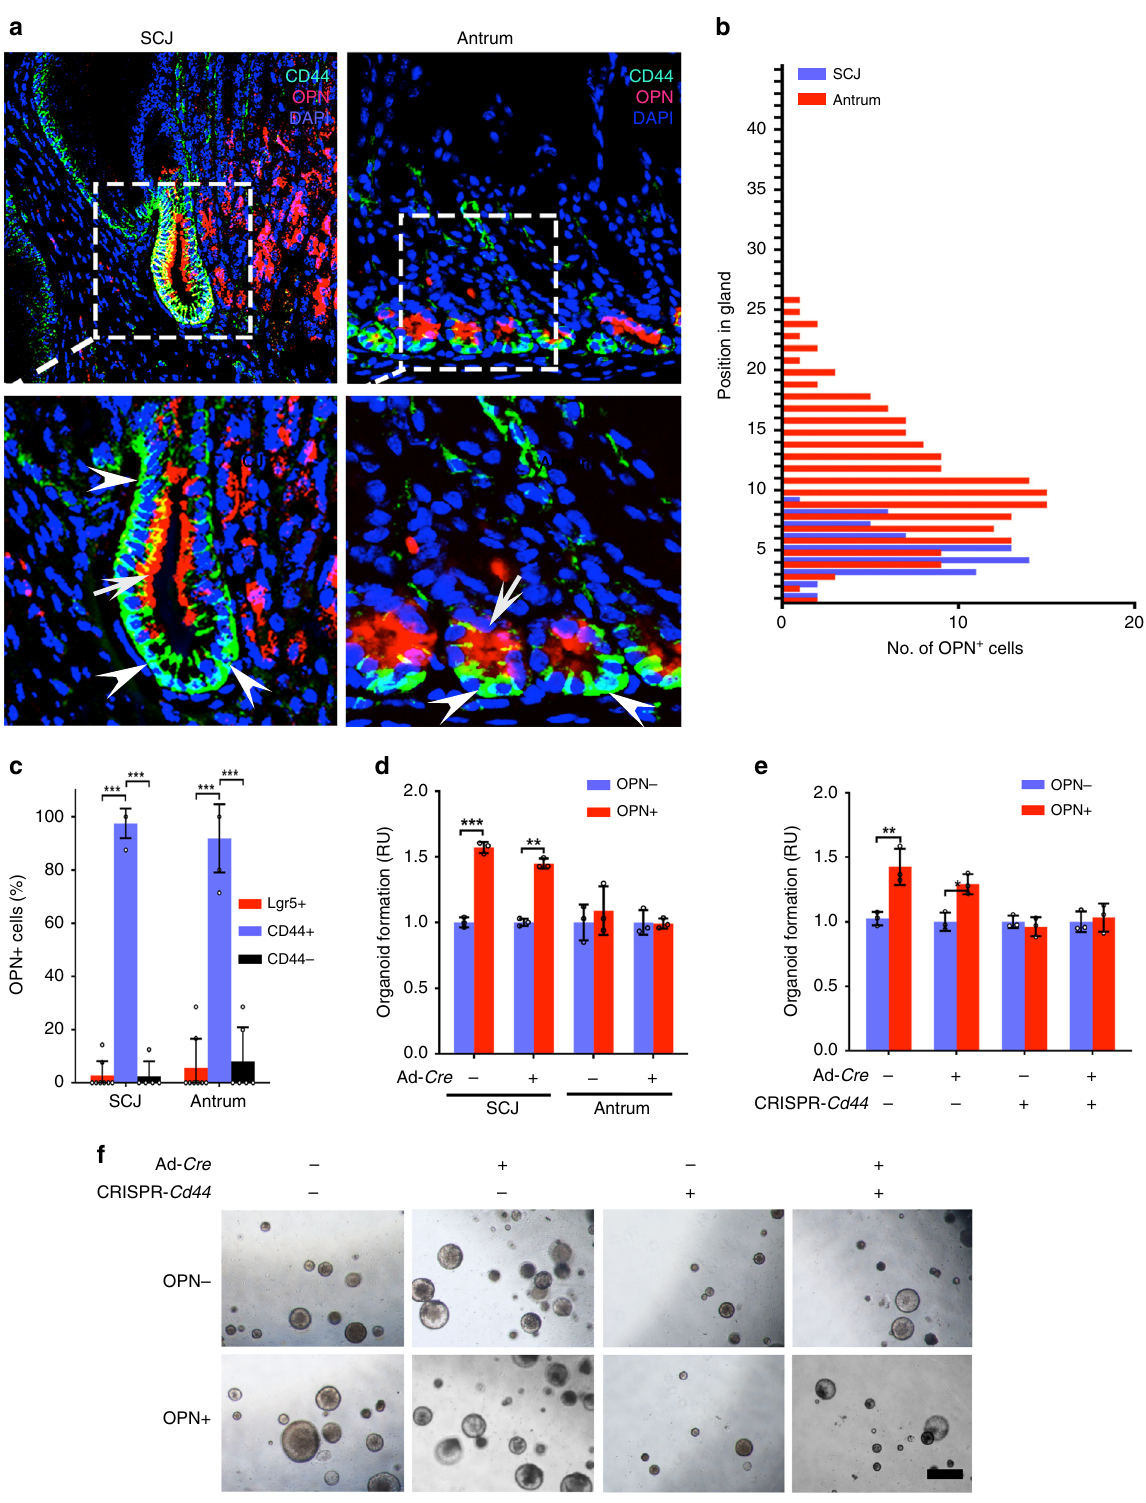
Fig. 5 Distribution of the OPN + cells in the gastric SCJ and antrum. a Detection of OPN (red, arrows) and CD44 (turquoise, arrowheads) in the SCJ and antrum of wild-type mice. Punctate rectangles in top row images indicate areas shown in the bottom row images. b Number of OPN + cells located at speci fi c positions in glands SCJ and antrum ( n = 20, each). c Fractions of the OPN + cells that express Lgr5 or CD44 within the regions as shown ( n = 05 or more). d The relative numbers of gastric organoids before (OPN − ) and after (OPN + ) exogenous OPN treatment. The organoid numbers were normalized to nontreated control in each group. e The relative numbers of SCJ gastric organoids before (OPN − ) and after (OPN + ) exogenous OPN treatment. The organoid numbers were normalized to nontreated control in each group. f Representative images of gastric organoids under various treatments as shown. DAPI counterstaining ( a ). Scale bar in f represents 25 μ m ( a , top panels), 12.5 μ m ( a , bottom panels), and 500 μ m ( f ). * P < 0.05, ** P < 0.01, *** P < 0.001, two-tailed unpaired t -tests. All error bars denote s.d. Source data are provided as a Source Data fi